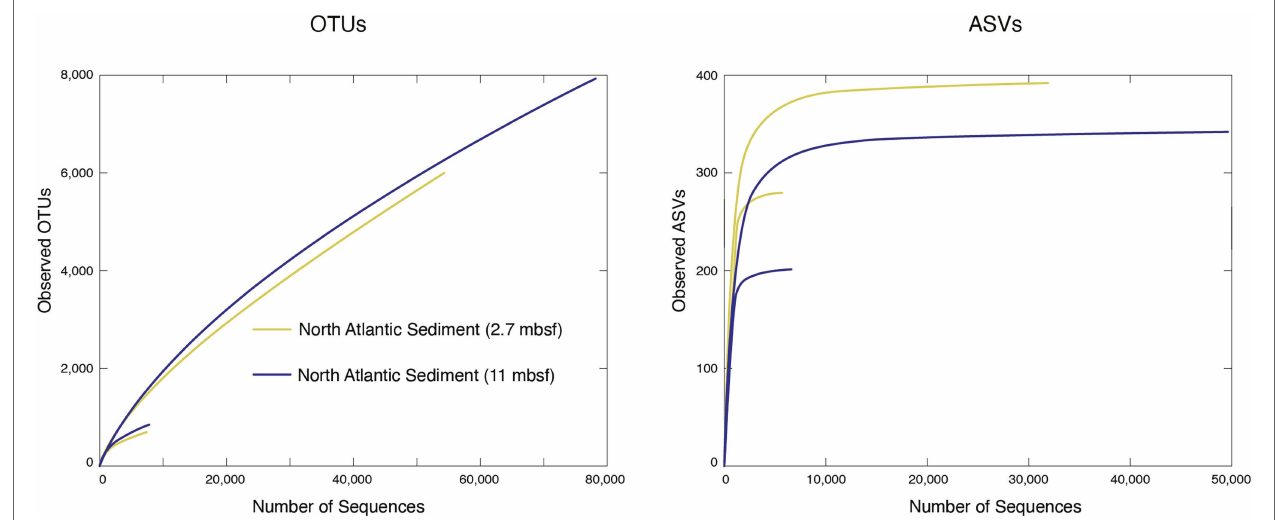
FIGURE 4 | Bacterial taxonomic abundance curves of operational taxonomic units (OTUs; left) and amplicon sequence variants (ASVs; right) for two marine sediment samples at both their full number of sequences, and a subsampled, 10,000-sequence data